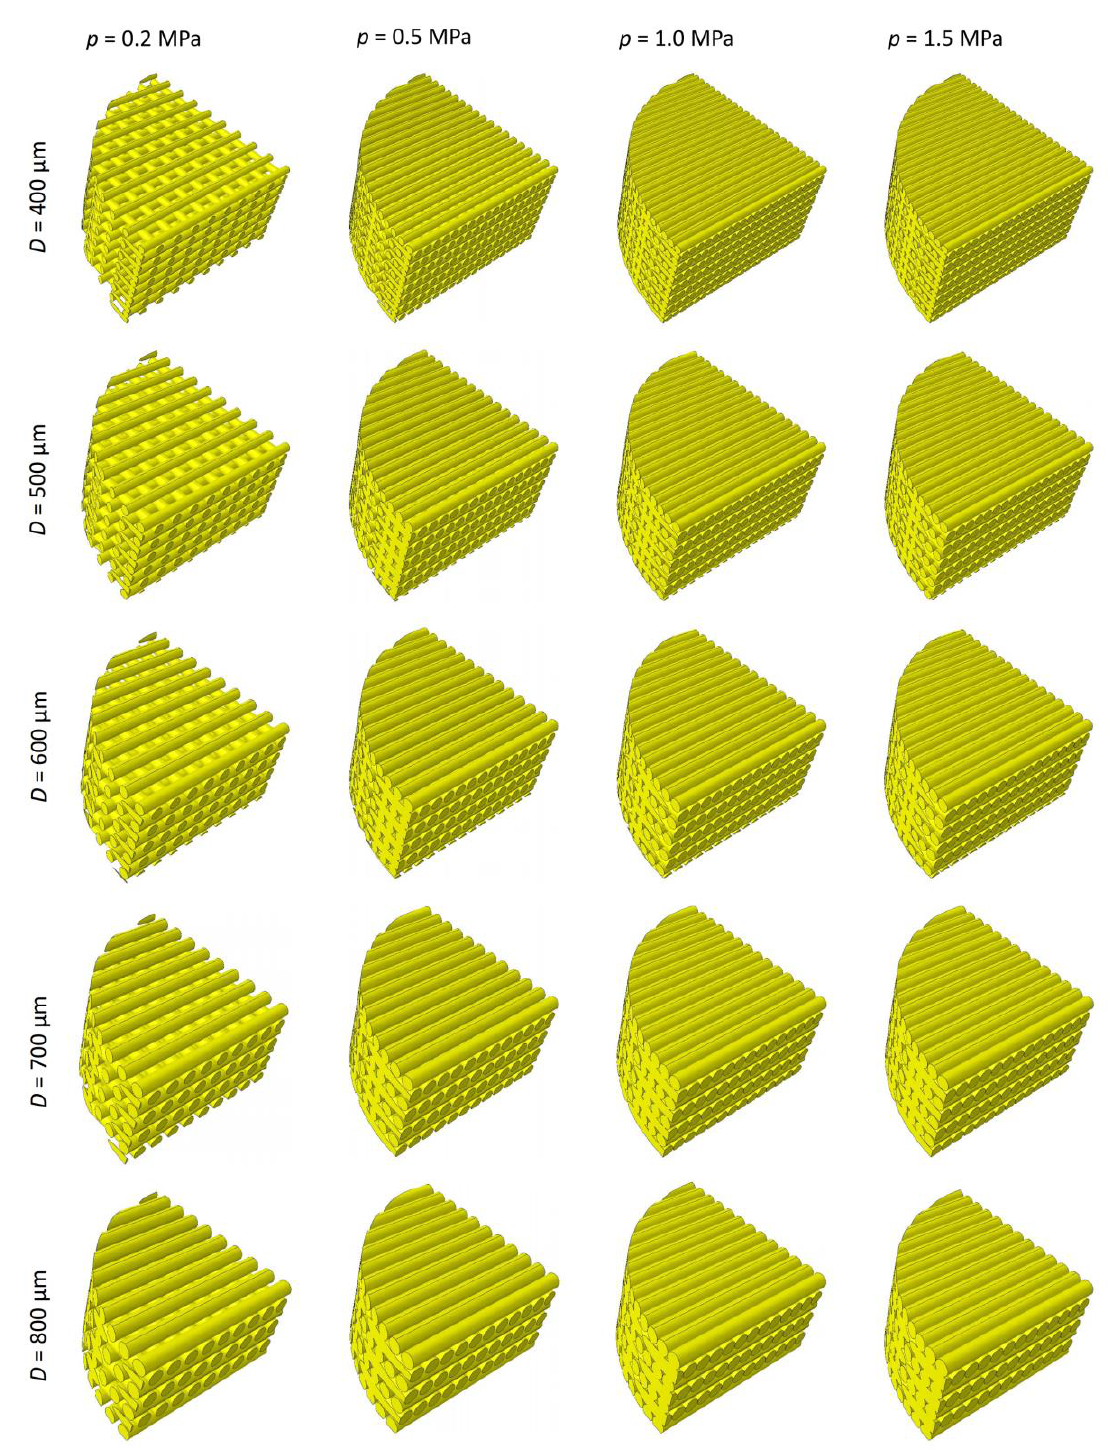
Figure 7. Optimal scaffold geometries predicted by the optimization algorithm for different values of the filament diameter D and the load per unit area p .